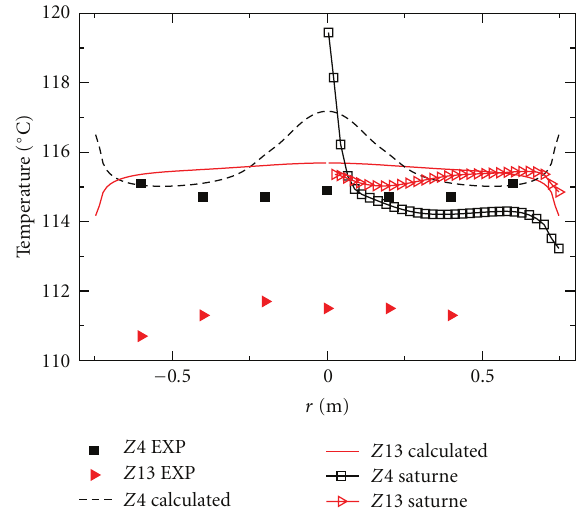
Figure 12: Radial profile of the steam molar concentration at Z 10 = 2 . 8m and Z 13 = 3 . 93 m: steady state 2.